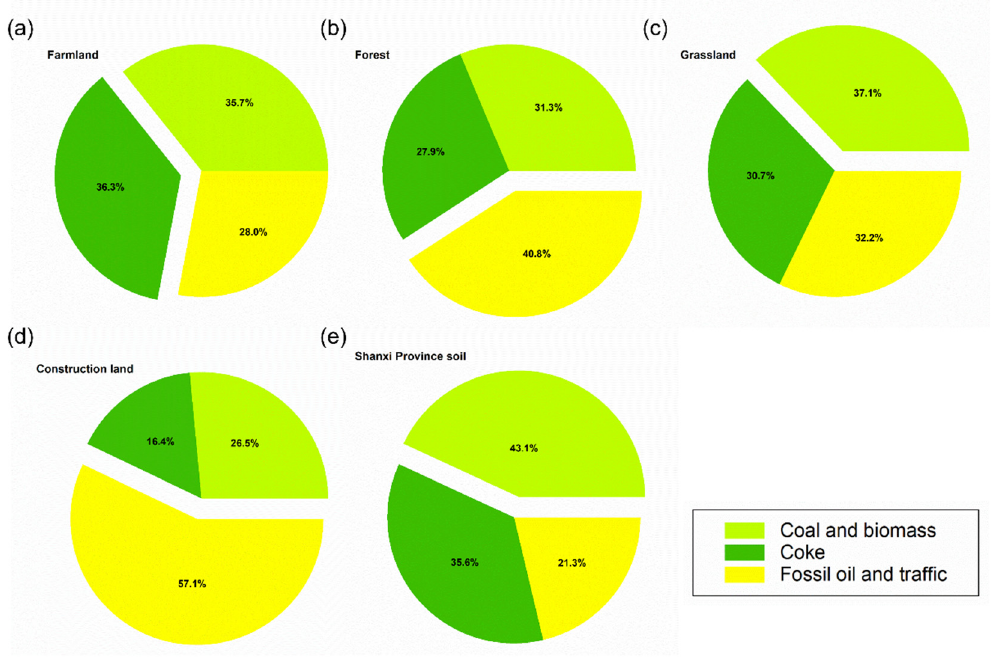
Figure 7. Source profiles and contribution of soil PAHs under farmland ( a ), forest ( b ), grassland ( c ), construction land ( d ), and all covers of land-use ( e ) obtained by PMF (positive matrix factorization).